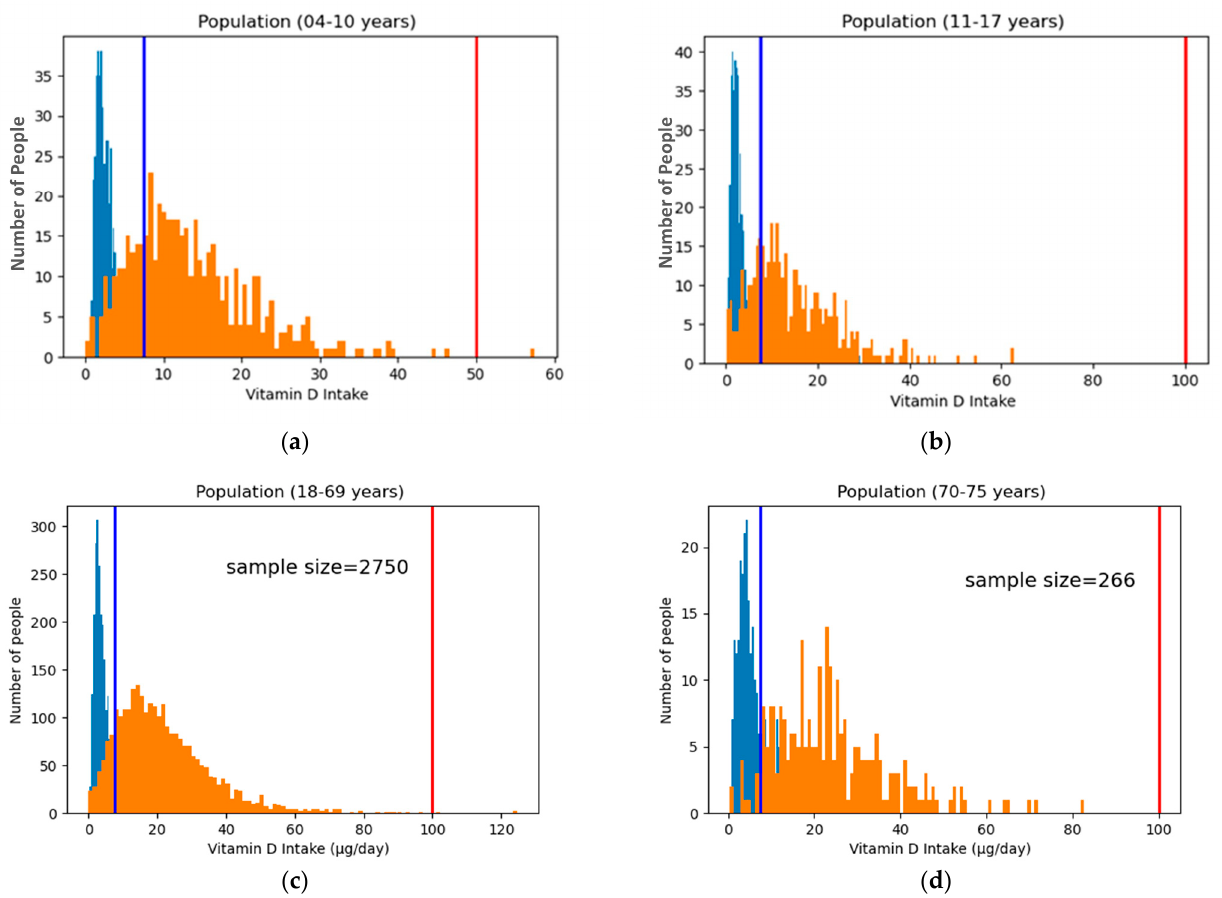
Figure 2. Individual age group distribution of vitamin D extracted from Model 1. These graphs show the effect of changes in each age range due to Model 1, which is trained on the entire population. The blue histogram represents the current vitamin D intake, whereas the orange histogram represents the new intake after fortification. The blue vertical line shows the AR, and the red line shows the UL: ( a ) intake distribution for the age group 4–10 years); ( b ) intake distribution in the age group 11–17 years; ( c ) intake distribution in the age range of 18–69 years; ( d ) and intake distribution in the age range of 70–75 years.